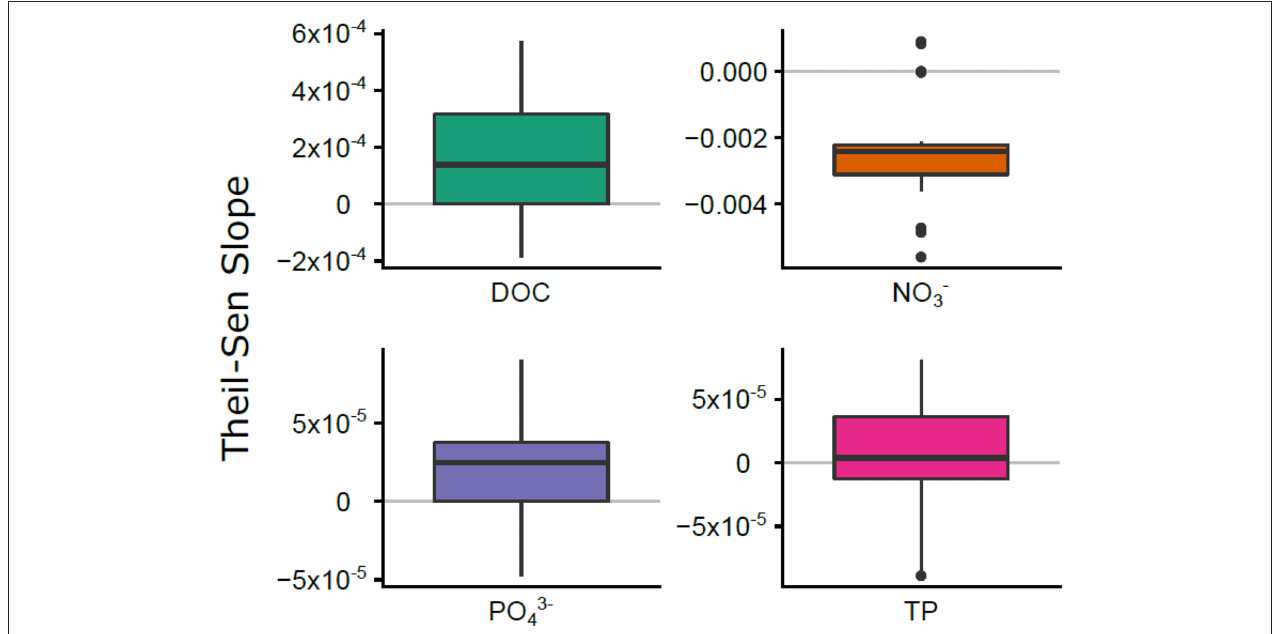
FIGURE 4 | The distribution of Theil-Sen nutrient slopes for C, N, and P for the 27 watersheds with long-term nutrient data. Horizontal gray lines indicate zero slope (no temporal trend).